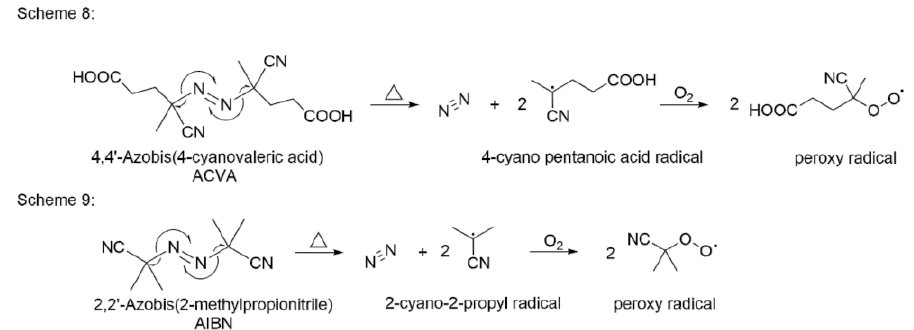
Figure 12. 4,4 (cid:48) -Azobis(4-cyanovaleric acid) and 2,2 (cid:48) -azobis(2-methylpropionitrile) mechanism of decomposition and reactions to peroxy